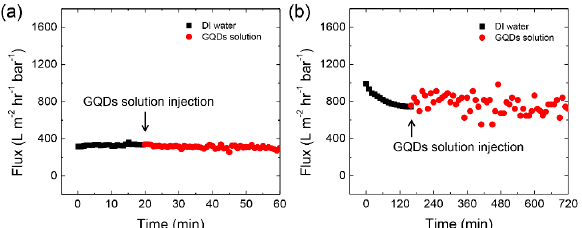
Figure 2. Permeability tests of graphene quantum dot (GQD) solutions with track-etched membranes operated in the two different modes. ( a ) Dead-end filtration and ( b ) cross-flow filtration.